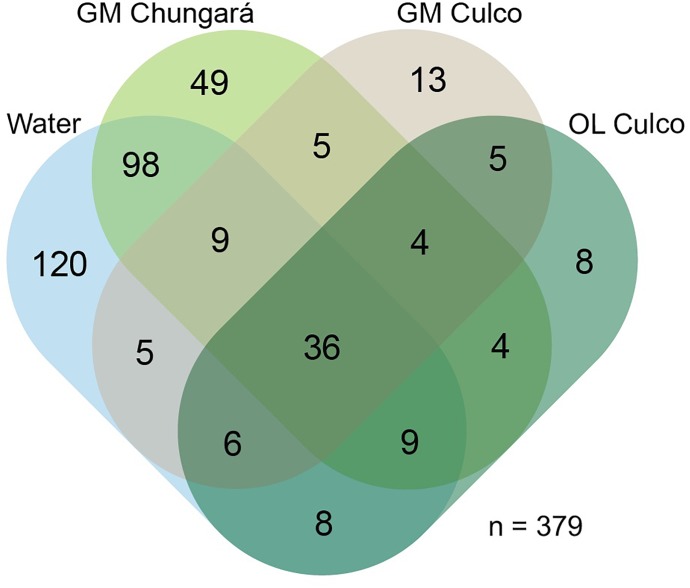
Venn diagram showing shared genera (including Nostoc sp.) among samples grouped by their origin: littoral lake water (Lake Chungará), inner gelatinous (Lake Chungará and Culco stream), and OL (Culco stream). GM, inner gelatinous matrix; OL, outer layer.